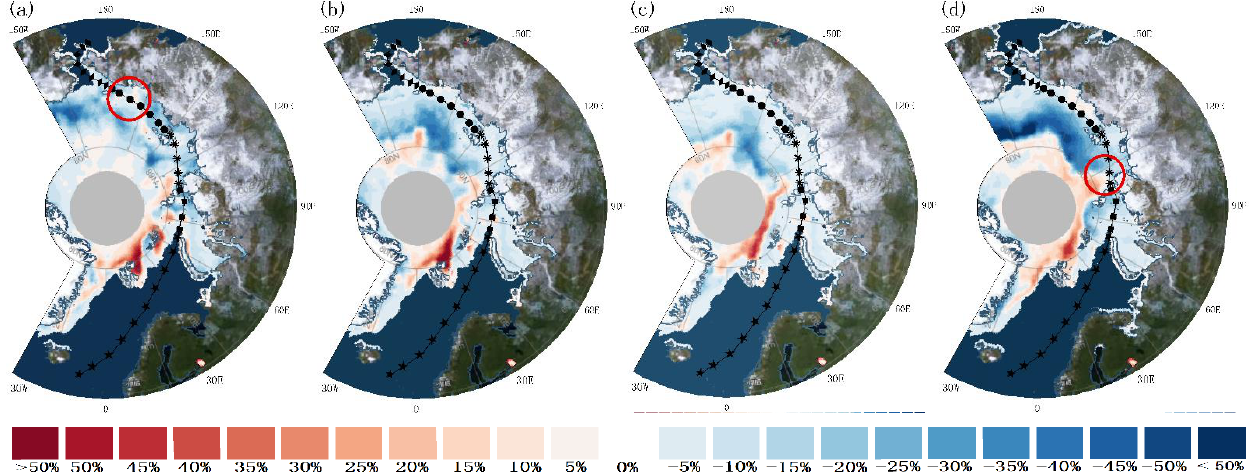
Figure 9. The anomalous distribution of sea ice concentration from July to October 2019 ( a – d ). (The outliers are based on the period from 2011 to 2020, the red circles represent the special areas).